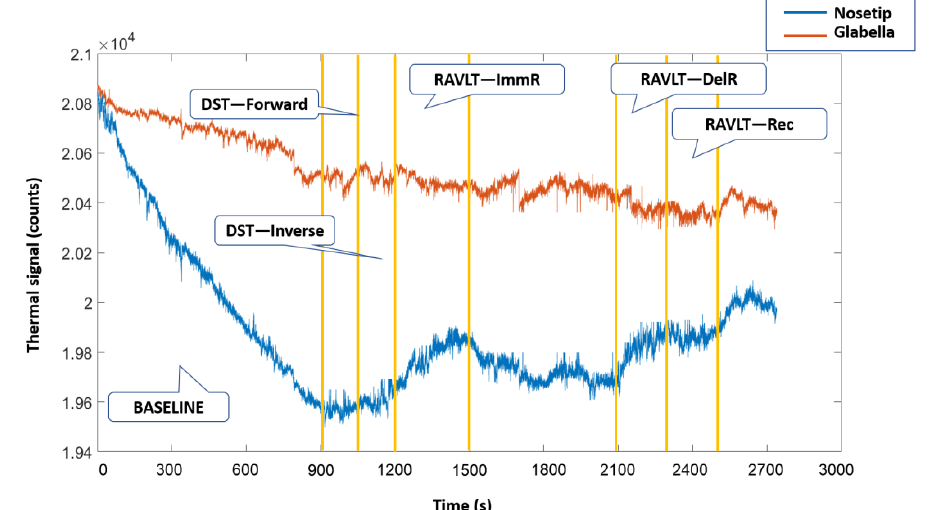
Figure A1. Thermal signals extracted from nosetip (in blue) and glabella (in orange) ROIs over the experimental phases.